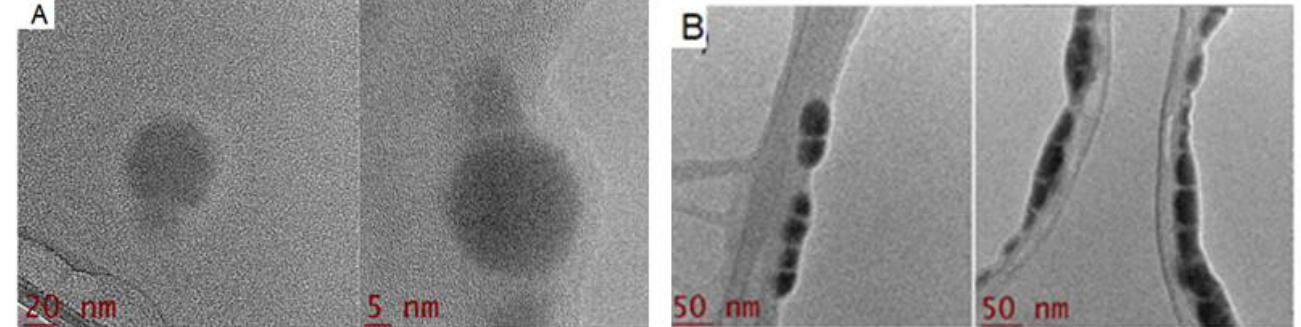
Figure 3. High-resolution transmission electron microscopy (TEM) images of SeNPs at 20 and 5 nm. ( A ) SeNPs derived from the COO depicting spherical nanoparticles ( B ) with bar scales of 20 and 10 nm.